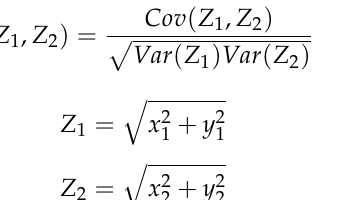
( a ) ( b ) ( c ) Figure 9. ( a ) Oil film pressure distribution in left piston pin boss. ( b ) Oil film pressure distribution in small-end bushing. ( c ) Oil film pressure distribution in right piston pin boss. In accordance with the previous section, the tribological characteristics of the bushing have the greatest impact on the performance of the entire machine, and only the lubrication performance of the bushing is analyzed in later sections. Based on the analysis of the piston pin lubrication characteristics, the final evaluation indexes were MOFT, maximum friction power, and MOFP. Research findings indicate that the influencing factors are A (oil temperature), B (oil supply pressure), C (surface roughness of bushing), D (surface roughness of journal), E (bearing clearance), and F (engine speed). There is a great deal of importance in determining the test level because if the amplitude of the level is too narrow, the results may not represent the expected result, whereas if the amplitude is too wide, the results may not be representative of the criteria. In this study, the level values are selected uniformly within the level range of the internal quantitative factors based on relevant research findings combined with engineering reality. According to the design requirements of the orthogonal experiment, ( ) N k m L m , m = 3, k = 6, and N = 3, where L represents the orthogonal table, m indicates the number of factor levels, k is the experimental influence factor, and m N indicates the number of times the test is conducted. An orthogonal experimental design reduces the number of experiments that